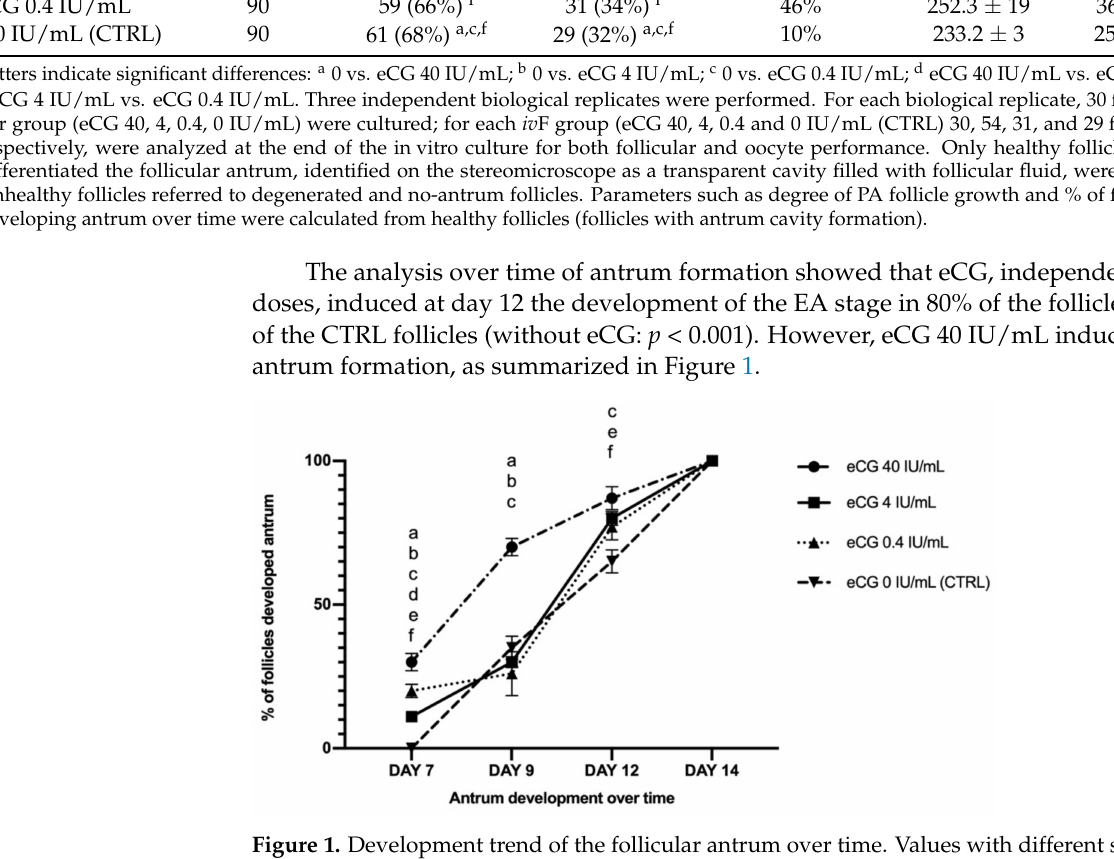
Figure 1. Development trend of the follicular antrum over time. Values with different